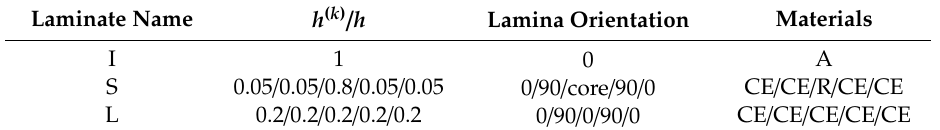
Table 2. Mechanical characteristics and material density of the unidirectional layers.